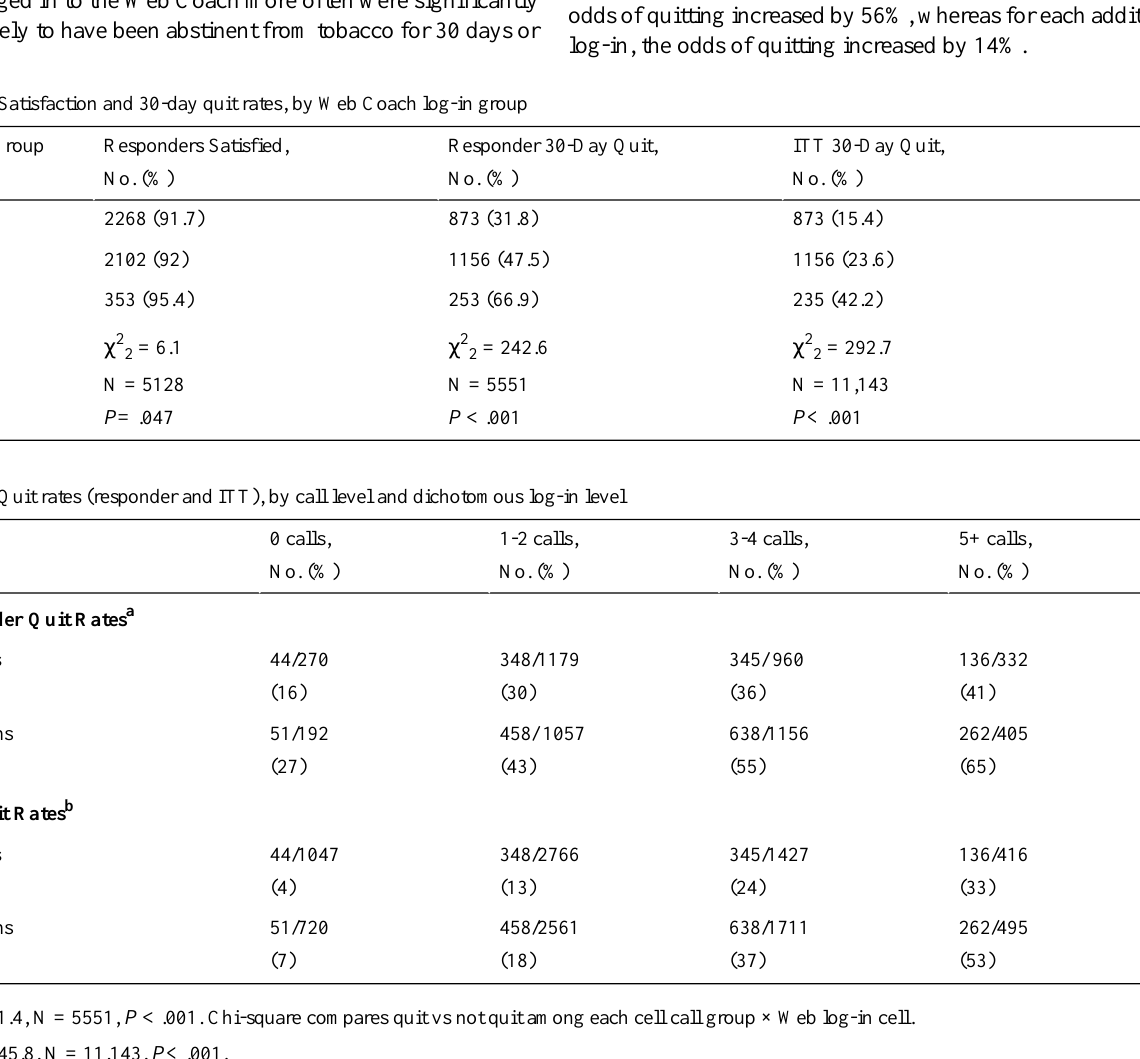
StatisticAverage Live Calls, Mean (SD)No. (%)Log-In Group